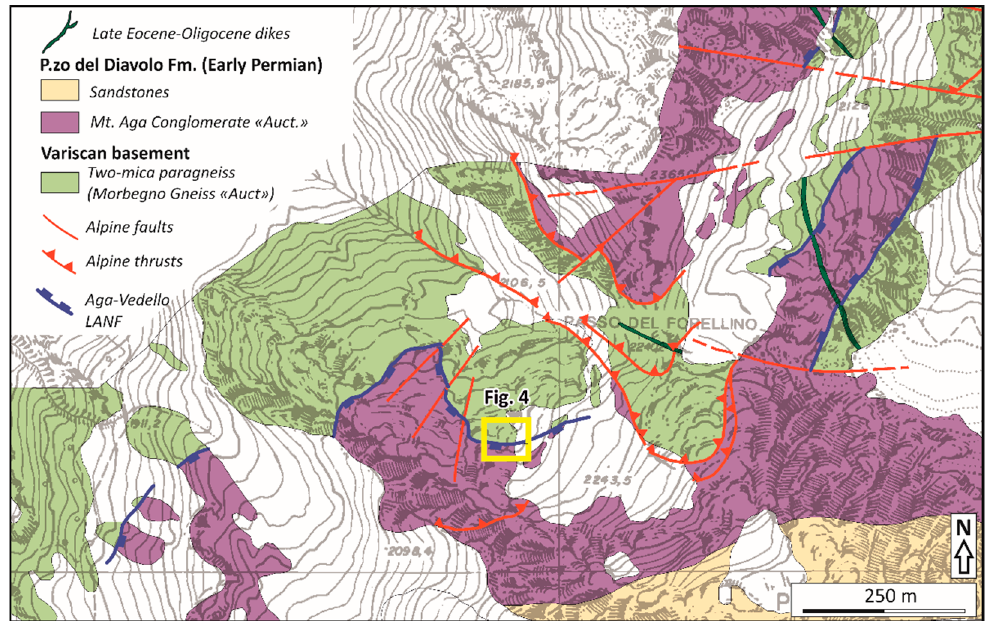
Figure 3. Geological map of the Forcellino Pass area. Parts of the Permian LANF are preserved both in the hanging wall and footwall of the Alpine thrusts. The best outcrops where the LANF structure is observable are in the footwall, at the center of the map (yellow box).